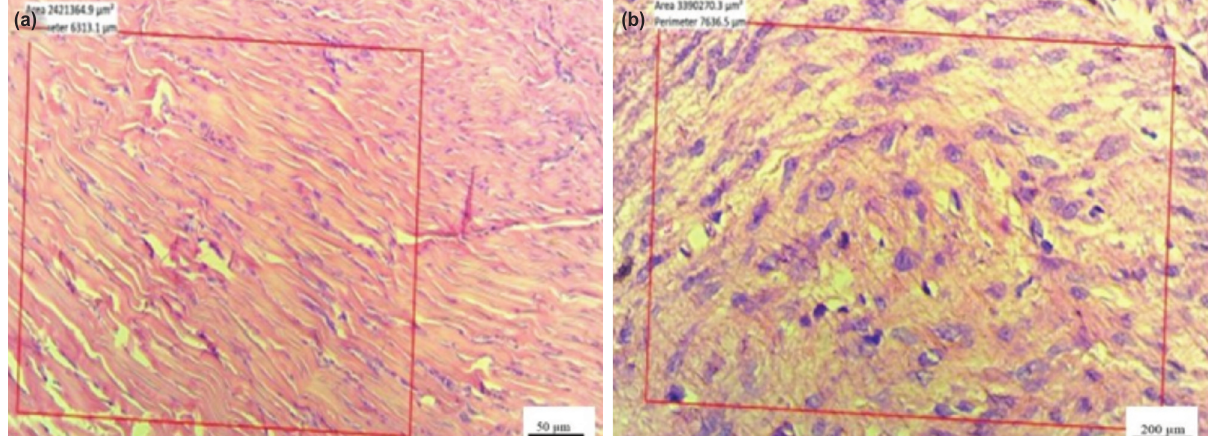
(a) Tissue samples of proliferation and cell density in the control and (b) doxycycline treatment groups. In the control group, Fig. 3: cells with dense, oval-shaped nuclei are seen, indicating a low activity of fibroblasts, which increased the rate of fibroblasts in the treatment group compared to the control group. (H&E magnification A 10×, scale bar 50 µm and B 40×, scale bar 200